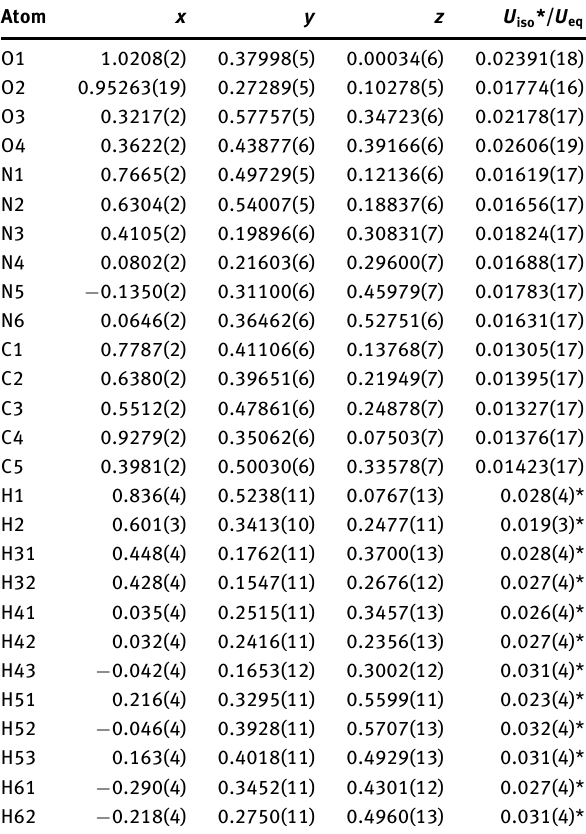
Table 2: Fractional atomic coordinates and isotropic or equivalent isotropic displacement parameters (Å 2